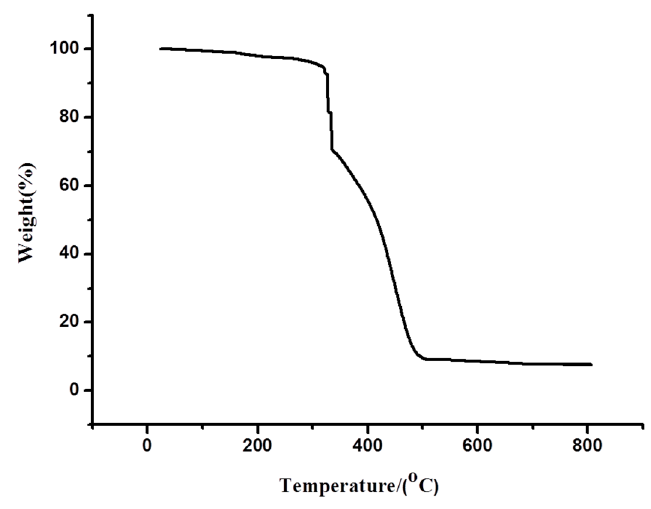
Figure 2. 19 F NMR spectrum of PSVE and PSVNa.